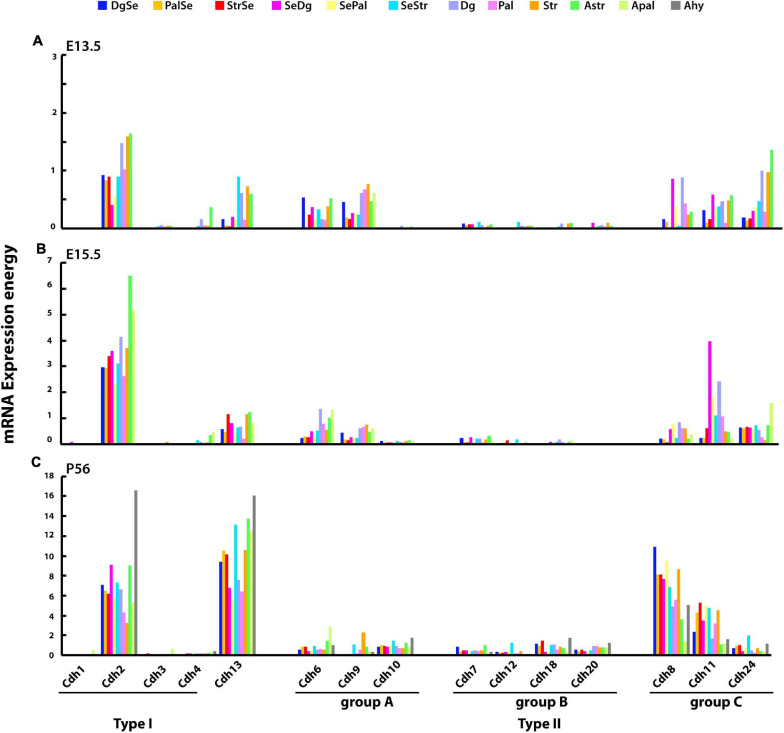
mRNA expression energy values of type I and type II cadherins and atypical Cdh13 in the developing subpallium. Bars display the mRNA expression energy of a cadherin in each neuroanatomical segment of the developing subpallium at ontological level 8 detected by ISH. (A) E13.5; (B) E15.5; and (C) P56. DgSe, diagonal part of septum; PalSe, pallidal septum; StrSe, striatal septum; SeDg, septodiagonal transition area; SePal, septopallidal transition area; SeStr, septostriatal transition area (accumbens); Dg, diagonal domain; Pal, pallidum (globus pallidus complex); Str, striatum (corpus striatum); AStr, striatal amygdala; APal, pallidal amygdala; Ahy, hypothalamic amygdala.